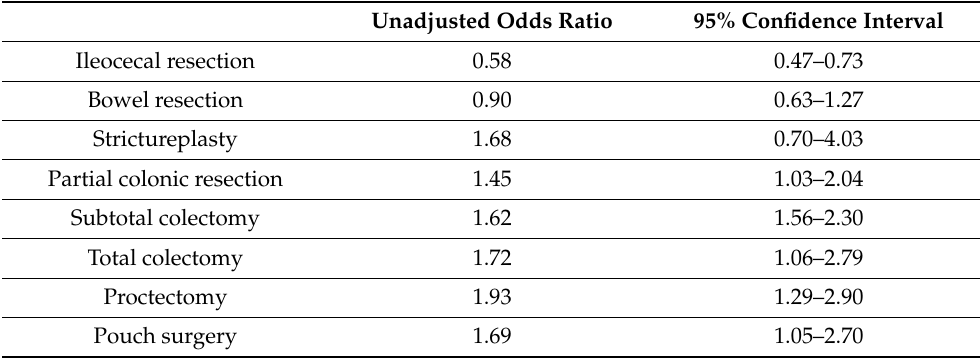
Table 4. Univariate analysis of surgical procedures as risk factors for postsurgical complications calculated by logistic